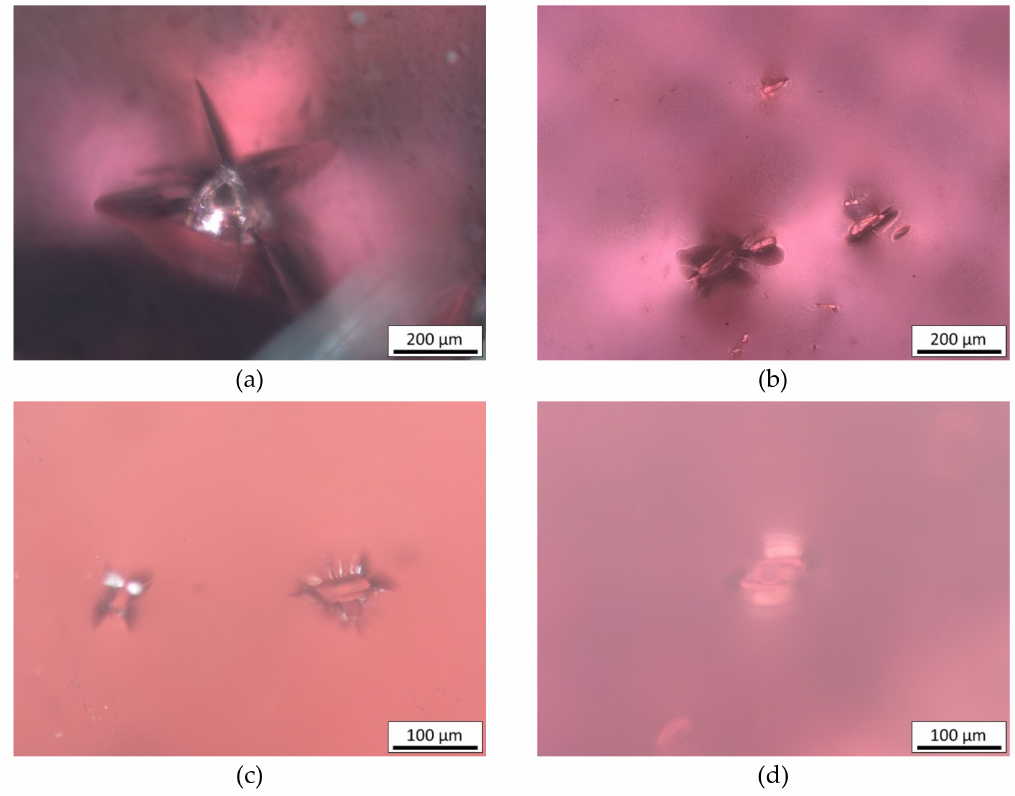
Figure 12. Inclusions with radiation deformations. Reflected light, parallel polars. ( a ) Inclusion with a pleochroic halo in garnet G2 of fibula NA843; ( b ) several inclusions with pleochroic halo in garnet G2 of fibula NA806; ( c ) small inclusions with pleochroic halo and probably tension fissures in garnet G2 of fibula NA247; ( d ) light radiation halo around inclusion in garnet G2 of fibula